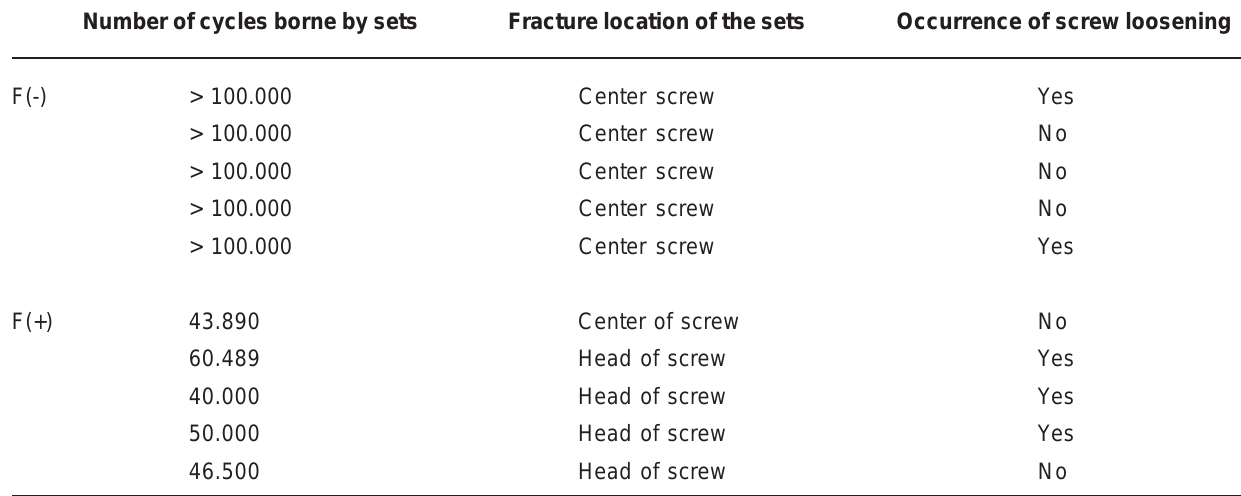
Note: > 100.000: Implant-abutment set that bears the total number of